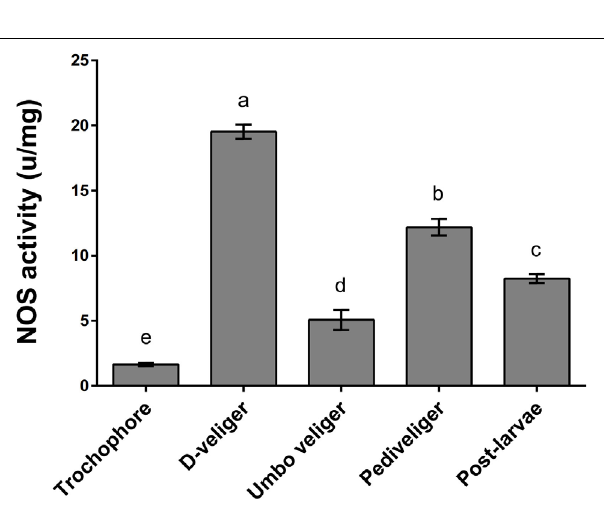
FIGURE 7 | Measurement of native NOS enzyme activity during different developmental stages of M. coruscus . Results are expressed as units of activity per milligram protein (U/mg). Values are means ± SEM ( n = 5), and bars with different letters are significantly different ( p < 0.05).